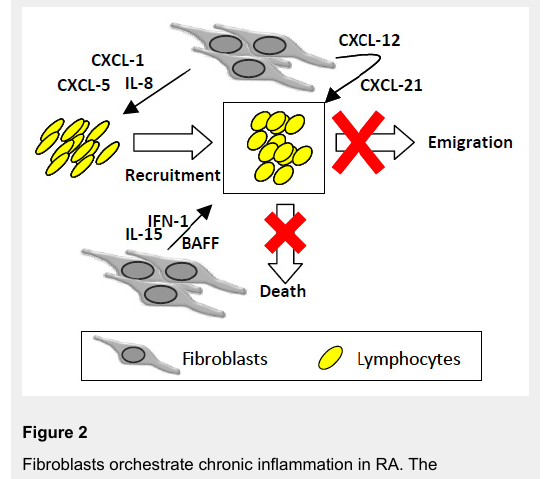
Fibroblast contribute to joint damage. Pannus tissue consists of activated RASFs that attach to and damage cartilage through production of MMPs and cathepsins. In addition, fibroblasts secrete RANKL, which promotes osteoclast differentiation and activation, leading to bone erosions. Furthermore production of DKK-1 inhibits Wnt signaling pathways that normally promote anabolic osteoblast activity, preventing repair of bone erosions. Abbreviations: MMPs: matrix metalloprotenaises; RANKL: receptor activator of nuclear factor k B ligand; DKK-1: